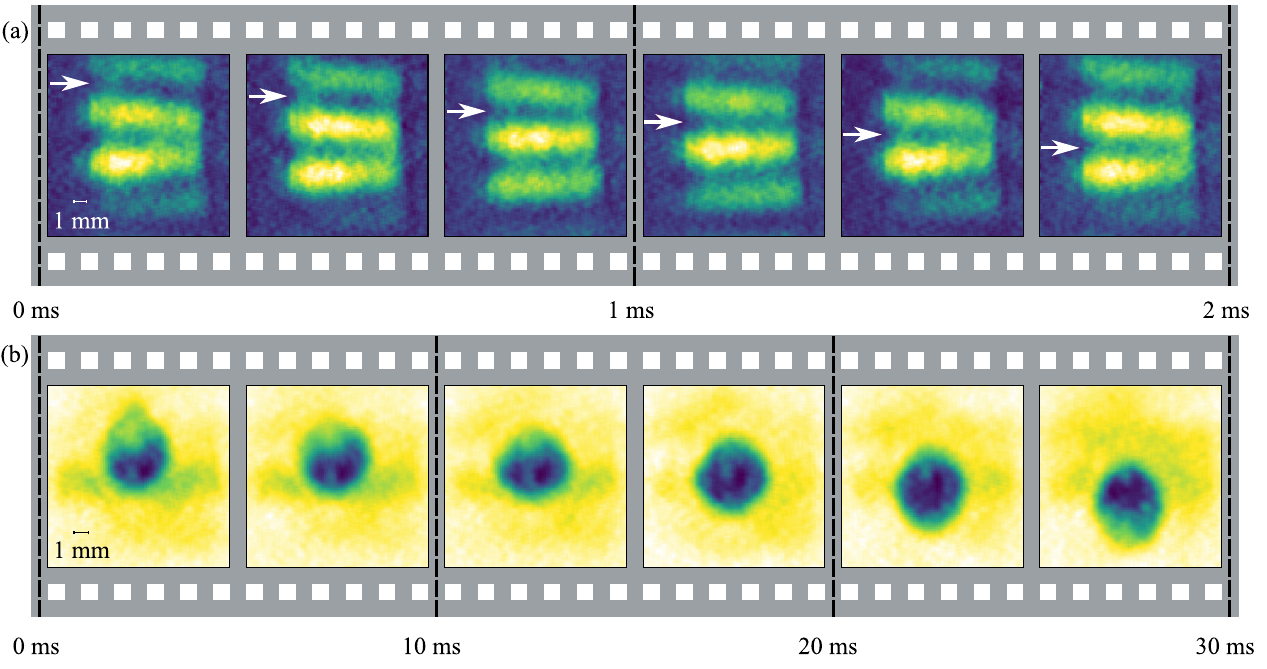
FIG. 3. Ultrahigh-speed THz video. (a) Subsequent frames from a THz video of an optical chopper wheel rotating at 700 rpm, imaged at a frame rate of 3 kHz. The white arrow is added to highlight the movement of one spoke of the wheel between frames. (b) A significantly slower frame rate of 500 Hz, is sufficient to capture the dynamics of a water droplet in free fall shortly after being released from a buret, every fourth frame of which is shown here. Full video files are available online